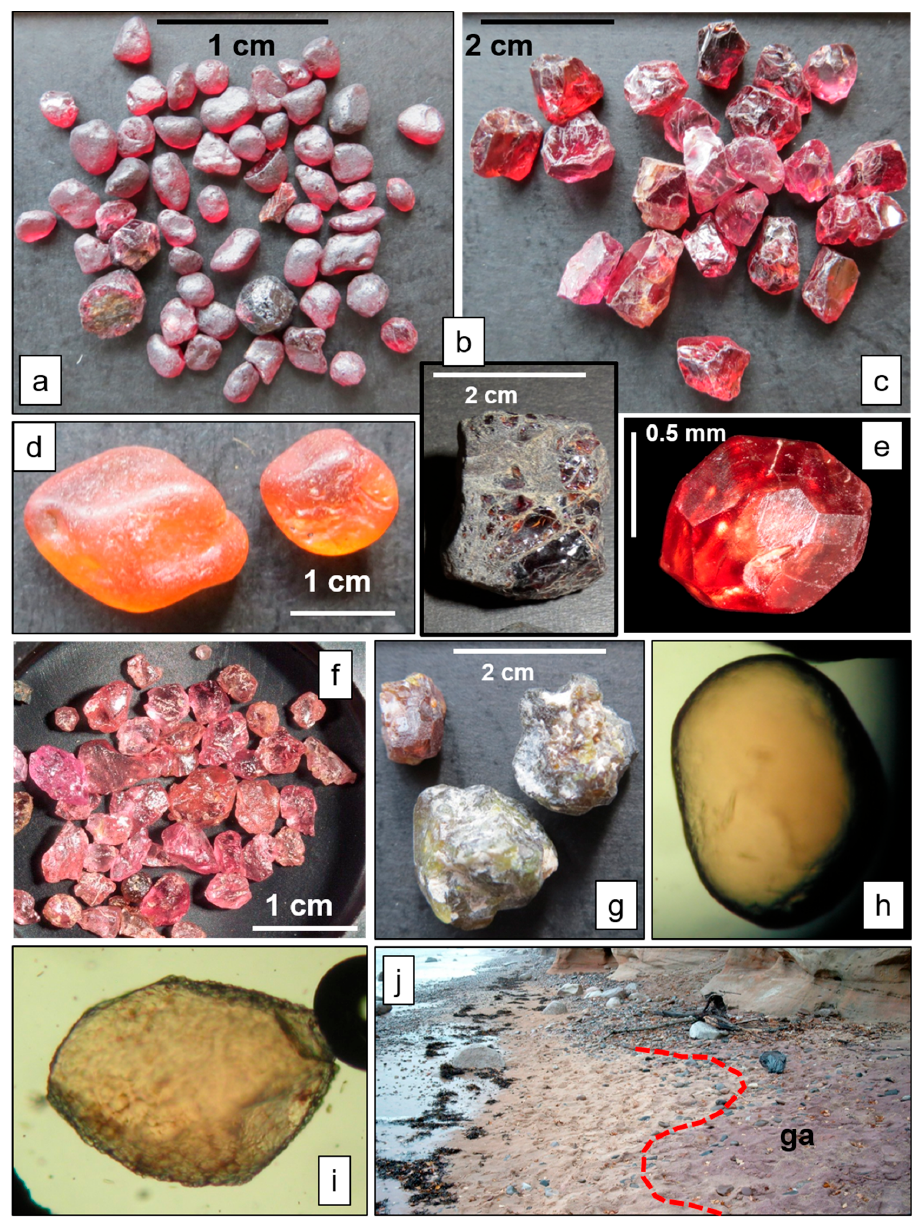
Figure 13. Garnet from placer deposits. ( a ) Well rounded pyrope-enriched garnet grains from fluvial placer, about 1 km downstream of the pyrope aggregate of Figure 13b. ( b ) Pyrope-enriched garnet cluster from a colluvial placer, Mongolia. ( c ) Rhodolite fragments from an alluvial placer, Madagascar. ( d ) Hessonite grains with beveled edges from an alluvial-fluvial placer, Tanzania. ( e ) Spessartine-enriched almandine garnet-group minerals, derived from pegmatitic and aplitic rocks from a fluvial placer (small creek), SE Germany. ( f ) Almandine garnet derived from paragneisses reworked into an alluvial-fluvial placer, SE Germany. ( g ) Grossular aggregates and grains from an alluvial placer, Malawi. ( h ) Micrograph of a well-rounded garnet from a beach placer (thin section, plane-polarized light, size approx. 300 µm), Bight of Riga, Latvia. ( i ) Micrograph of an angular garnet with etch pits from a residual to alluvial placer, (thin section, plane-polarized light, size approximately 300 µm), Malawi. ( j ) Small arenaceous strand plain with a cliff carved out of Devonian sandstones (Veczemji Cliff, Latvia). The garnet accumulation (“red sands”) of the beach placer in the backshore is marked by a red dashed line from the seaward clean white beach sand spread across the